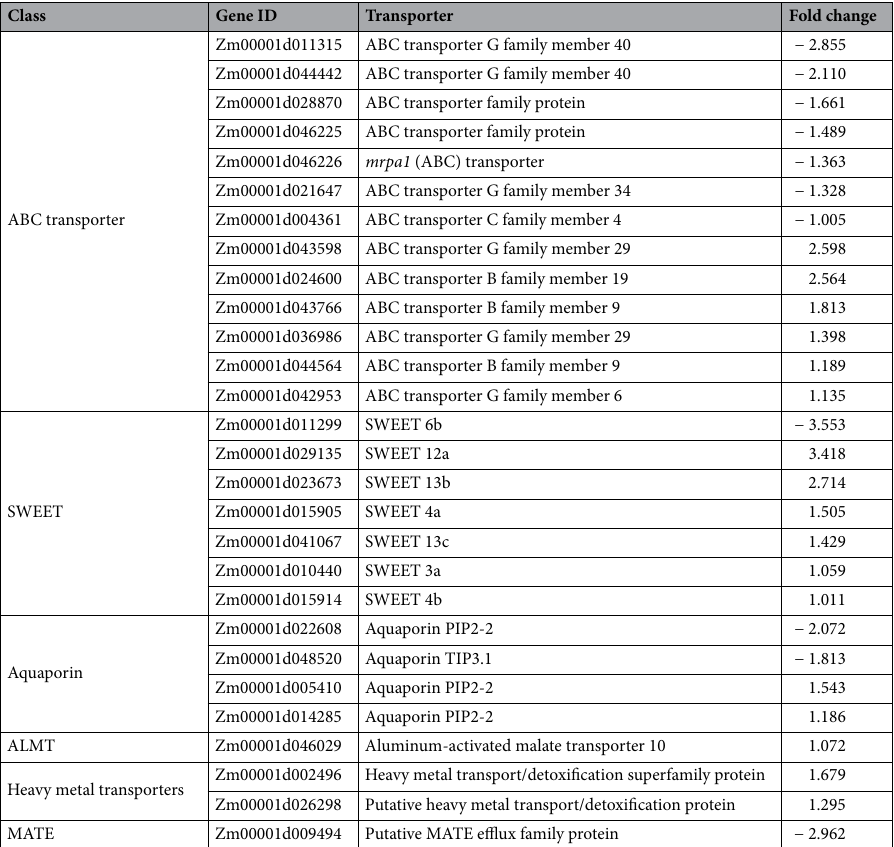
Table 2. Aluminum responsive transporters related to Al-resistant line inbred